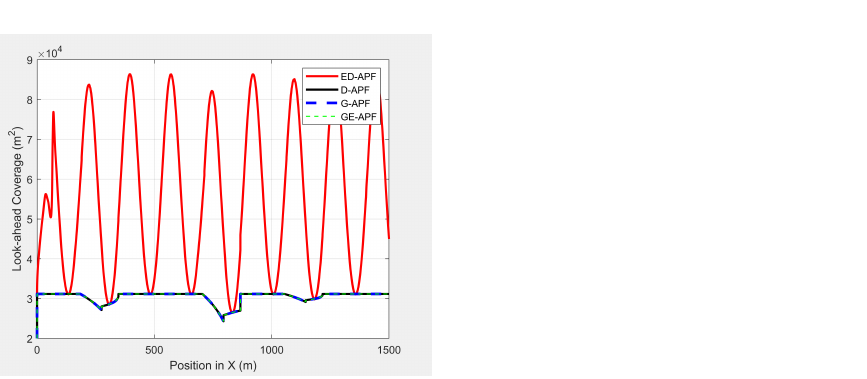
Figure 32. Look-ahead distance along the X-axis vs. the MGV’s position while moving in an environment with different objects.